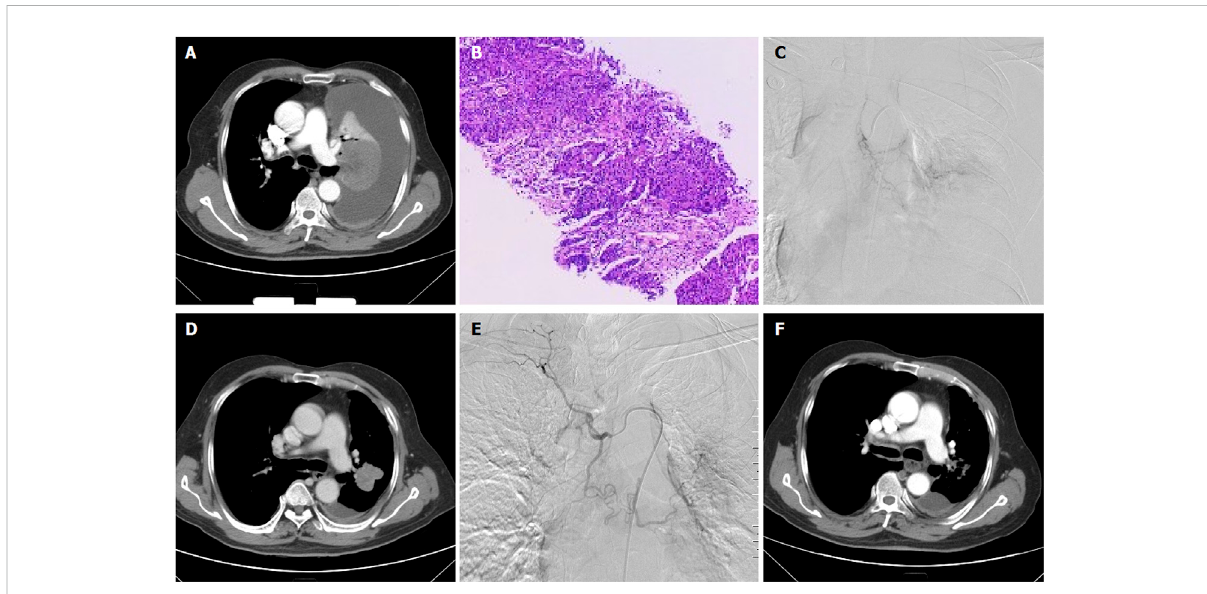
FIGURE 4 A 66-years male treated by CalliSpheres beads for advanced squamous cell carcinoma in left lung. (A) Computed tomography examination before procedure revealed malignantcentral tumor of leftlung, with complete atelectasis and massivepleural effusion. (B) Pathologicaldiagnosis of squamous cell carcinoma by biopsy of the lesion. (C) The left lung tumor was treated by CalliSpheres beads. (D) The left lung tumor shrunk and atelectasis disappeared 1 month after the fi rst session of DEB-TACE. (E) The left tumor was treated again by drug-loaded beads 1 month later. (F) The tumor was almost disappeared 3 months after fi rst